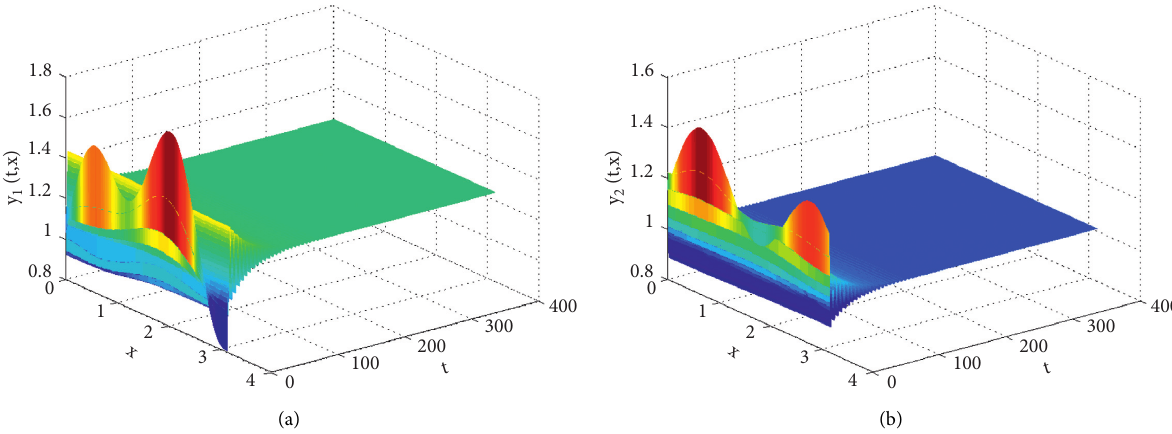
Figure 1: The positive constant steady state of the system with Neumann boundary is locally asymptotically stable for τ + τ � 2 . 3633. (a) Spatial distribution of y τ � τ < τ 0 1 2 0